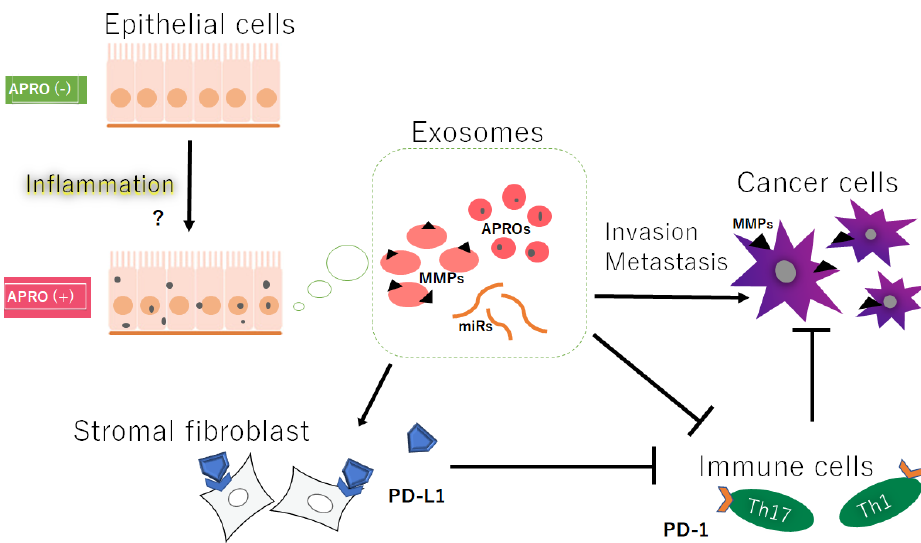
various cancers.